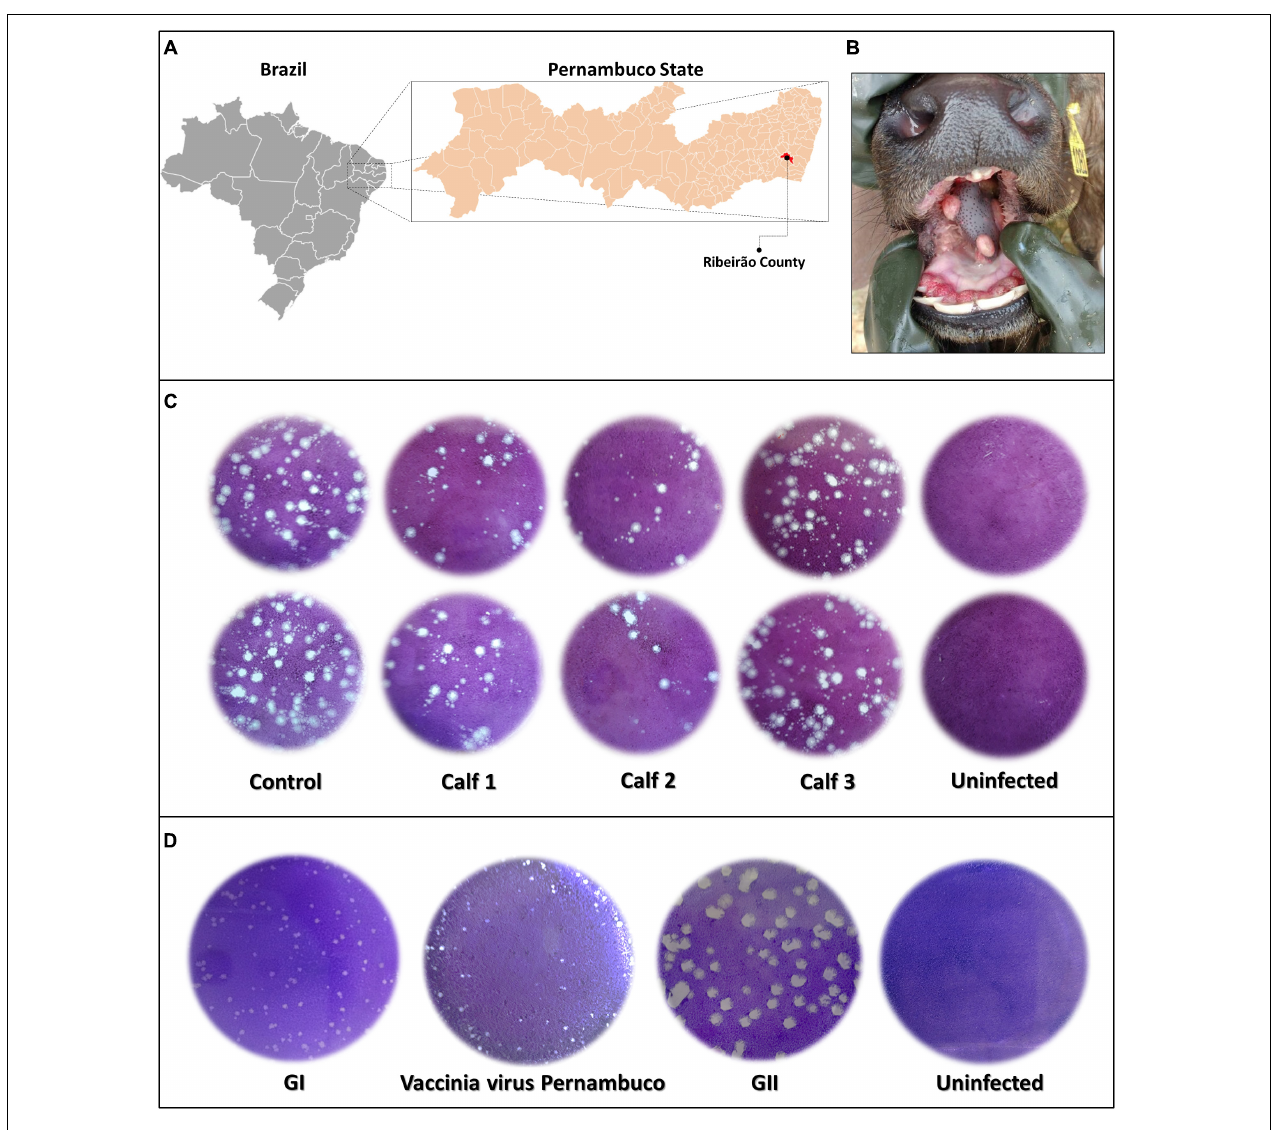
FIGURE 2 | Outbreak localization, lesions, and viral lytic plaque. (A) Map displaying localization of the outbreak in Ribeirão County, Pernambuco State, Brazil (08 ◦ 30 (cid:48) 11 (cid:48)(cid:48) S and 35 ◦ 22 (cid:48) 26 (cid:48)(cid:48) W) and incidence of vesicular lesions on the tongue of buffalo calves (B) . Plaque reduction neutralization test of calves’ serum samples diluted in a 1:40 ratio (C) , and plaque phenotypic assay of vaccinia Pernambuco isolate and control Brazilian vaccinia viruses of GI and GII (groups I and II) (D) .